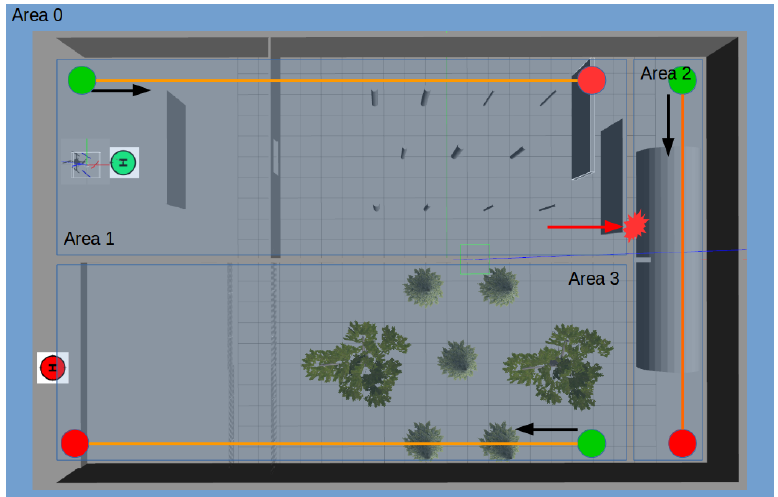
Figure 10. This diagram shows the top view of the dynamic environment and the sections of the